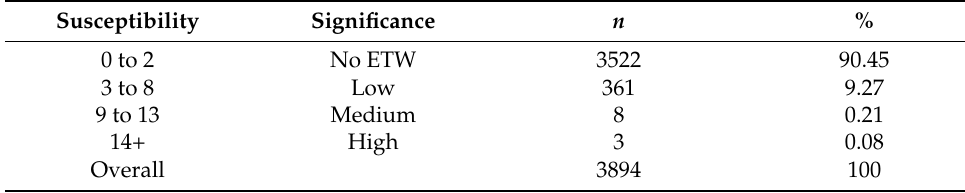
Table 4. Shows the degree of susceptibility of the patients included in the application.